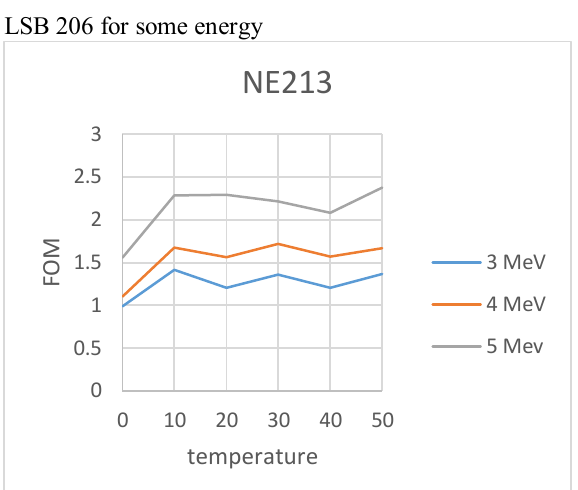
Fig. 7. FOM temperature dependence of the NE213 for some energy VII. It can be seen from the graphs that the FOM temperature dependence is neither linear nor monotonic. The reason for the non-linearity will be the subject of further research. Knowledge of the FOM temperature dependence of scintillators allows eliminating this dependence in calculations of energy spectra of measured neutron-gamma mixed radiation. R